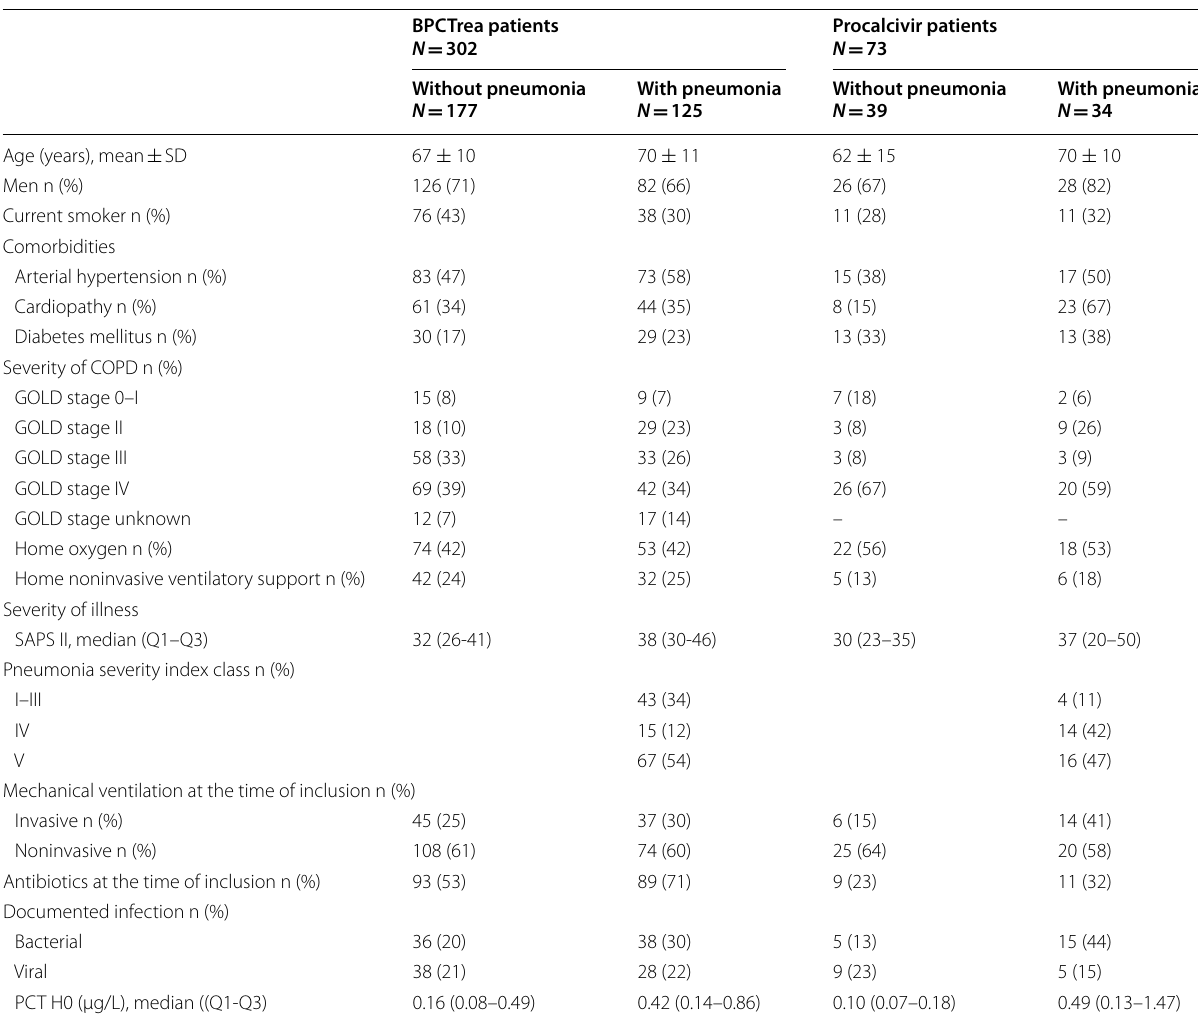
Table 1 Patient